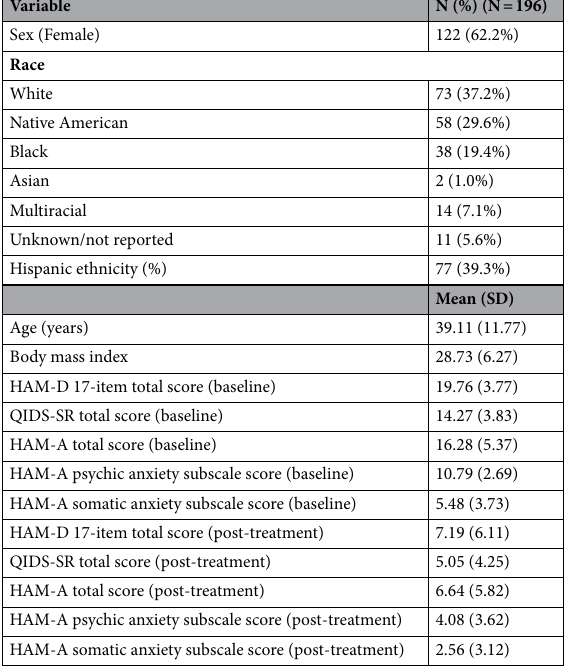
Table 1. Subject demographic and clinical characteristics. HAM-A Hamilton Anxiety Rating Scale, HAM-D Hamilton Depression Rating Scale, QIDS-SR Quick Inventory of Depressive Symptomatology,